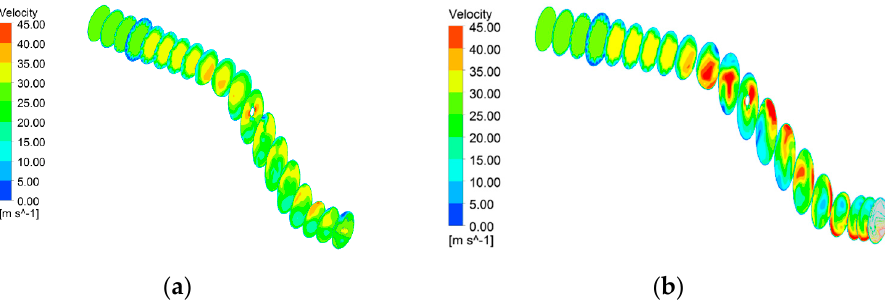
Figure 8. The velocity distribution: ( a ) the double-layered pipe; ( b ) the single-layered pipe. The turbulent kinetic energy is an important indicator in evaluating the turbulent mixing. An increase in turbulent kinetic energy can promote the mixing of the UWS and exhaust, and then accelerate the decomposition of urea. The turbulent kinetic energy distribution of exhaust is shown in Figure 9, along the central axis of the exhaust bellow and front exhaust pipe. The turbulent kinetic energy significantly changed at the position of the urea nozzle in both the double-layered pipe and the single-layered pipe. Before reaching the urea nozzle, the turbulent kinetic energy of the fluid in the double-layered pipe is higher than that in the single-layered pipe. After the fluid flows through the urea nozzle, the turbulent kinetic energy distributions in the double-layered pipe and the single-layered pipe are closer. In general, the turbulent kinetic energy in the double- layered pipe is higher than that in the single-layered pipe. The reason for the surge of turbulent kinetic energy near the urea nozzle is that the velocity of the exhaust at the inlet of the mainstream is 40 times that of UWS. So, the UWS obtains kinetic energy from the exhaust, and this causes a drastic perturbation at the gas and liquid interface when the UWS is injected into the exhaust pipe [29]. The maximum turbulent kinetic energy was 67,715 m 2 /s 2 in the double-layered pipe, while it was 957 m 2 /s 2 in the single-layered pipe. Figure 9. The turbulent kinetic energy distribution. The atomization effect is an important index in evaluating the decomposition of UWS [30]. Based on turbulent kinetic energy distribution, the atomization of UWS was studied in the front exhaust pipe. The cumulative volume percentage is shown in Figure 10, which was obtained by the Rosin–Rammer function. d 0.5 is the corresponding diameter of UWS droplets when the cumulative volume percentage is 50%. d 0.9 is the corresponding diameter of UWS droplets when the cumulative volume percentage is 90%. By comparing the cumulative volume percentages of UWS droplets in the double-layered pipe and the single-layered pipe, it was found that when the diameter of the UWS is less than 85.6 μ m, the volume fraction of small droplets in the double-layered pipe is higher. When the -0.4